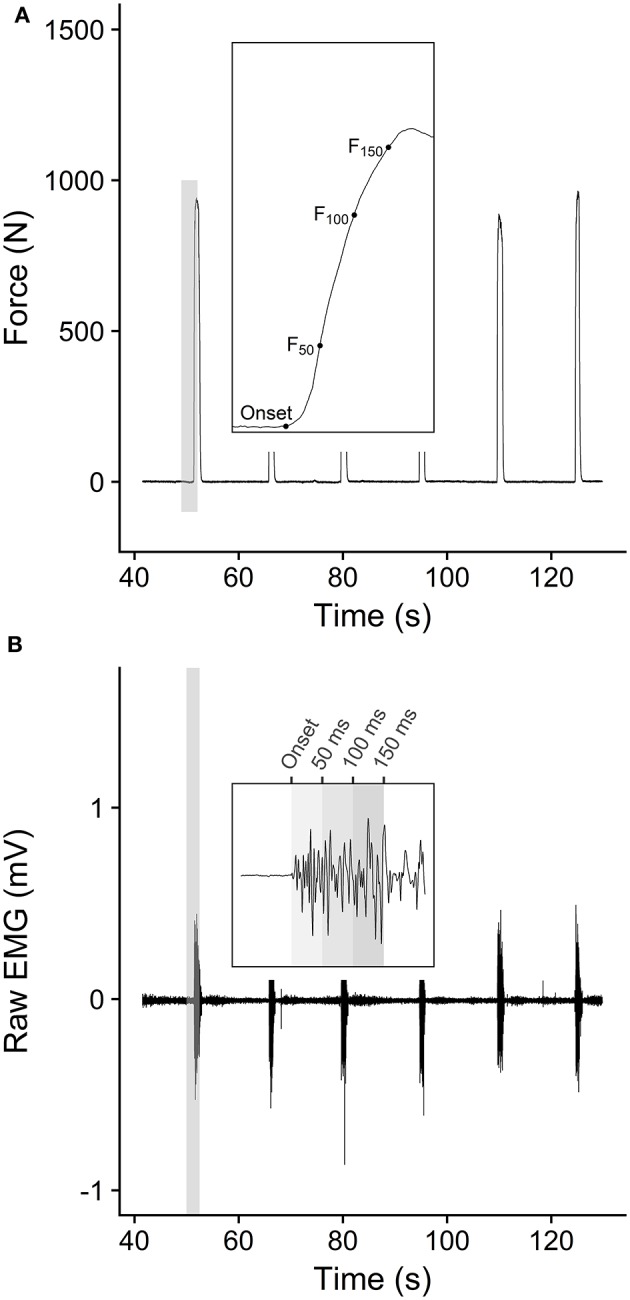
(A) Typical example of force trace during an isometric explosive strength assessment. Each force onset was automatically detected as the last zero-crossing point on the first derivative of the filtered signal force (de Ruiter et al., 2007), and force values at 50, 100, and 150 ms were compared. (B) Typical example of EMG recording during the isometric contractions. Signal onset was manually identified and the root means square (RMS) was averaged across 0–50 ms, 50–100 ms, and 100–150 ms time periods after onset.